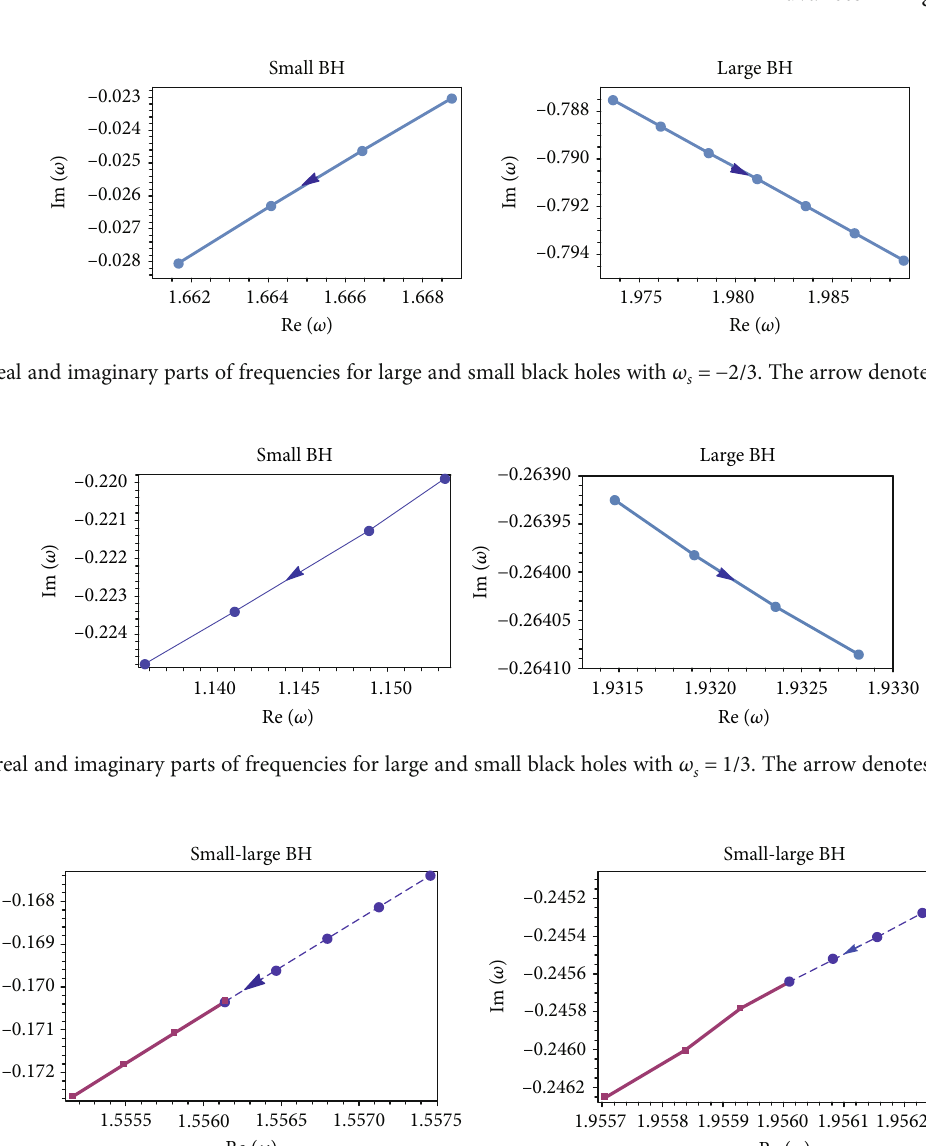
Figure 7: The real and imaginary parts of QNM frequencies for large (dashed) and small (solid) black holes. The arrow denotes the increase in the horizon